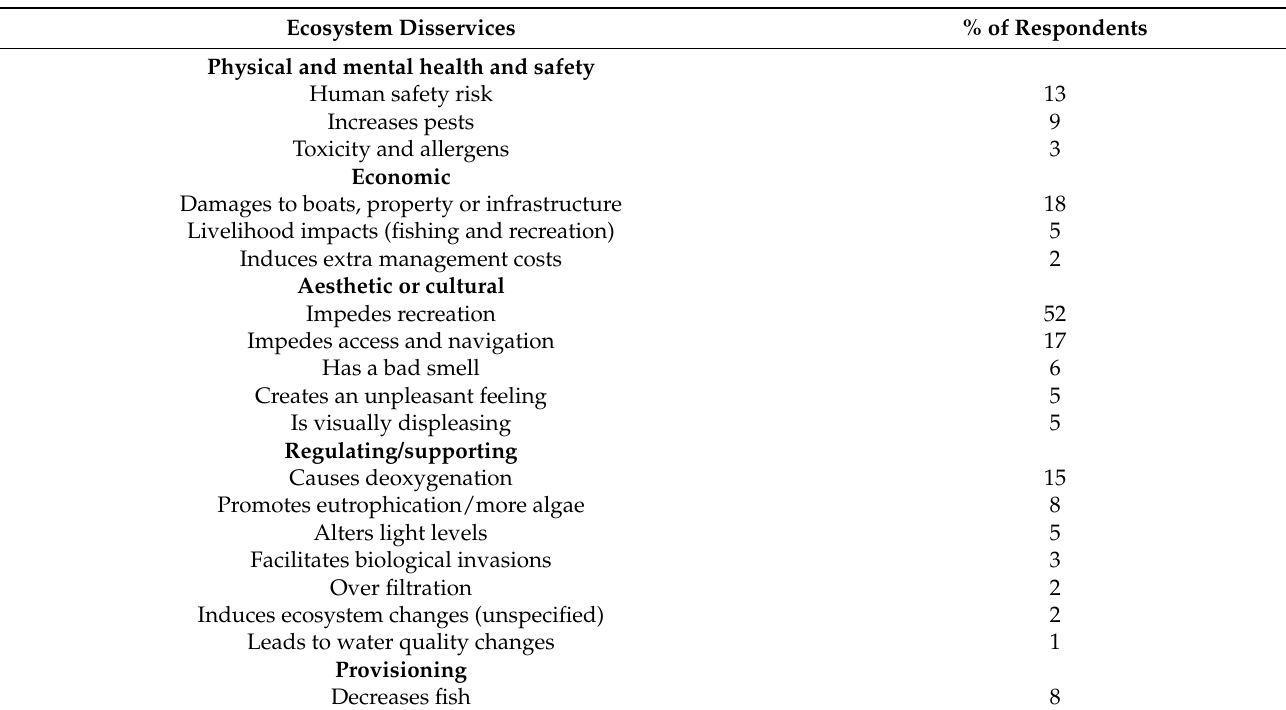
Perceived negative impacts of aquatic plants categorized into various ecosystem disservices based on Shackleton et al. (2016) [14] and this study. Note that percentages add up to more than 100 as many respondents mentioned more than one negative impact. Only the responses from the semi-structured questionnaires were included in